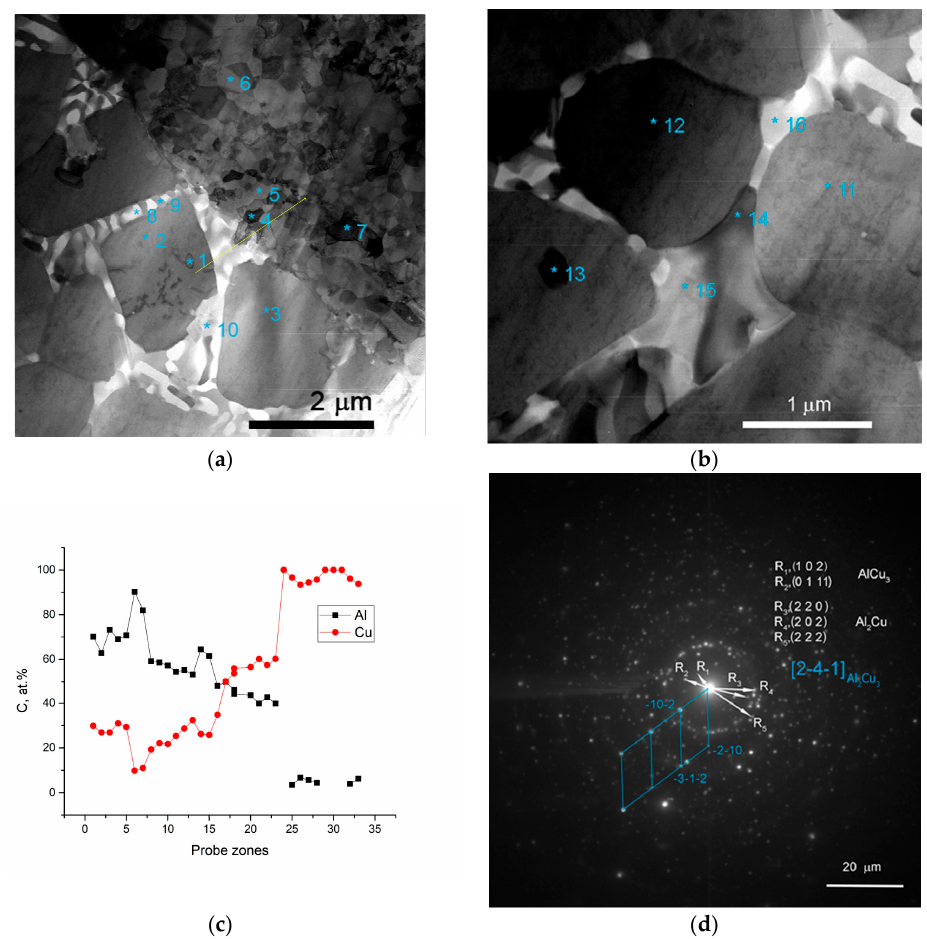
Figure 5. TEM images of SZ areas: Al-Cu interfaces with eutectics ( a , b ); EDS profile across the Al 2 Cu / Cu transition zone ( c ); SAED pattern obtained from the area in Figure 5a and SAED reflection identification ( d ); 1–15 are the EDS probe spots corresponding phases shown in Table